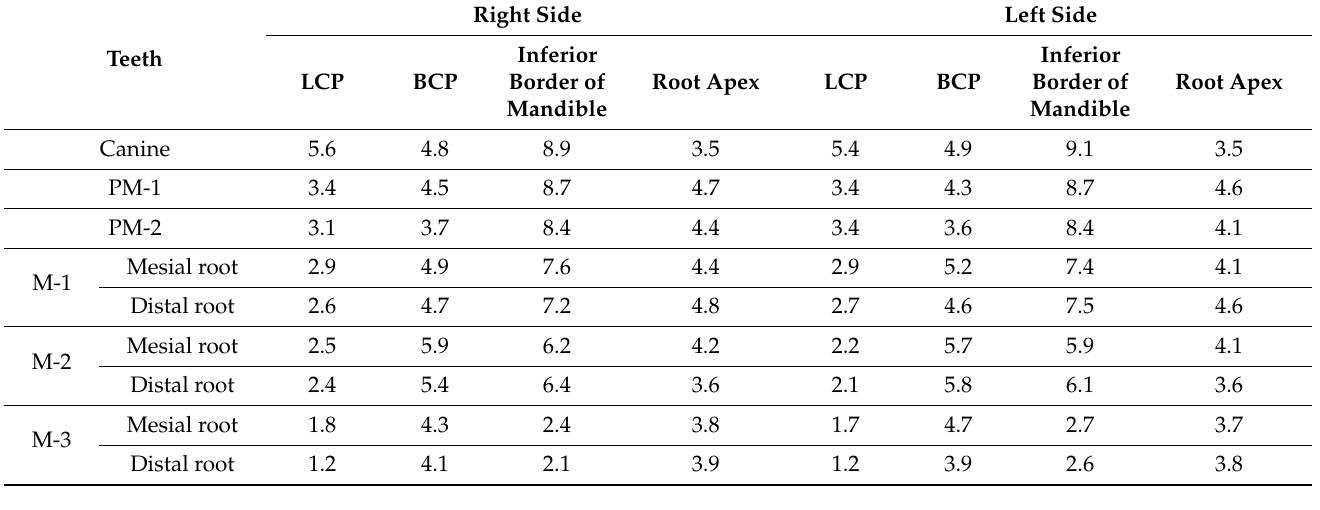
Table 1. Shortest mean distance (mm) from the IAC to the LCP, BCP, inferior border of the mandible, and root apex bilaterally.